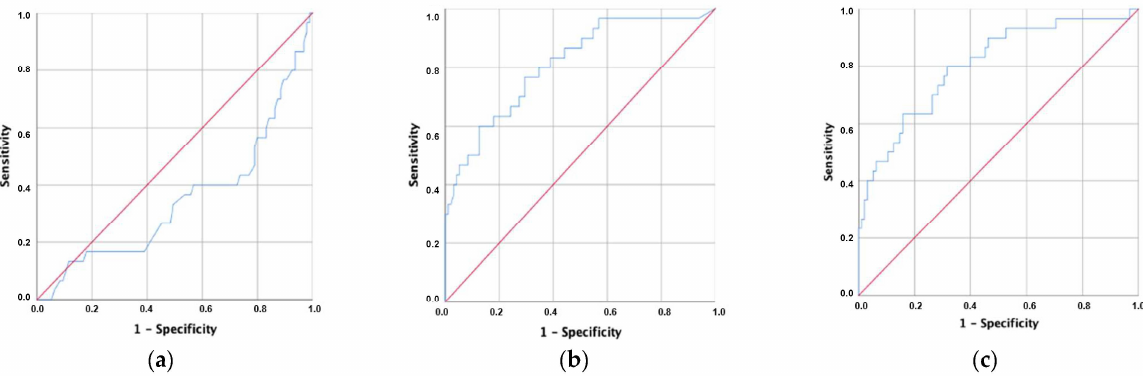
Figure 3. ROC curves of hemoglobin ( a ), C-reactive protein ( b ), and C-reactive protein-to-hemoglobin ratio ( c ). The sensitivity of the CRP/Hb score (cut-off = 1.32) in the discharge for hospitalization was 80.0%, and the specificity was 68.4% for patients arriving at the emergency